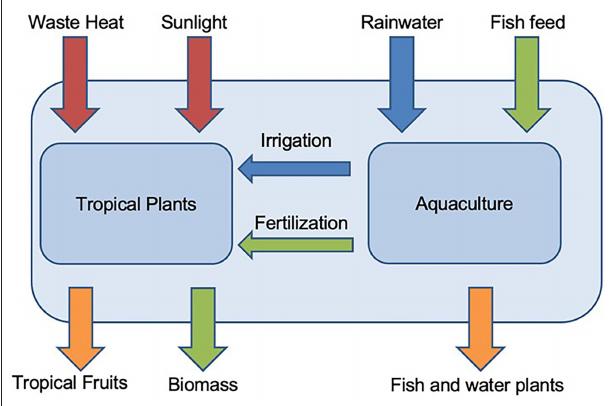
FIGURE 1 | Process streams greenhouse system “Kleineden” (adapted from Schmitt,